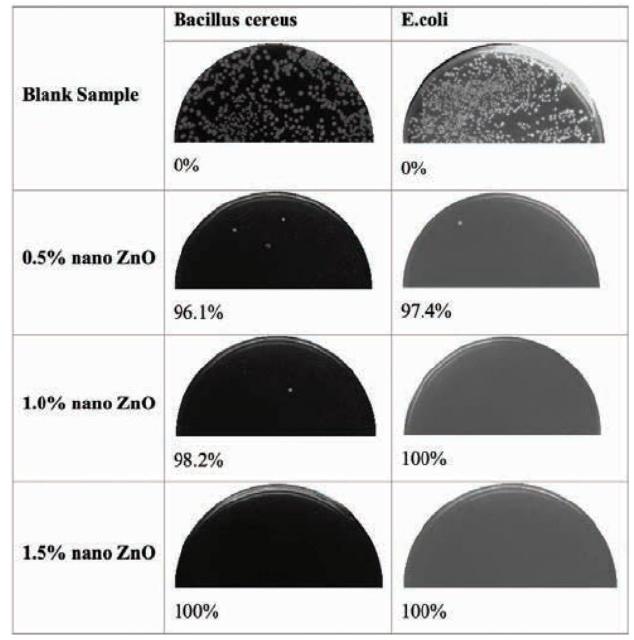
Figure 7. Antibacterial efficiency of blank and treated samples [101]. Table 2. Antimicrobial activity of all electrospun samples with variation in aloe vera and ZnO NPs against S. aureus and E. coli